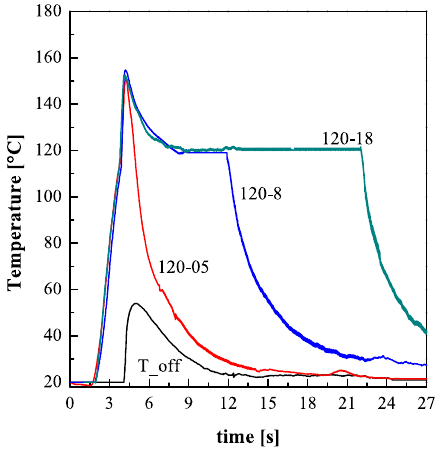
Figure 2. Temperature evolutions measured during tests reported in Table 1.